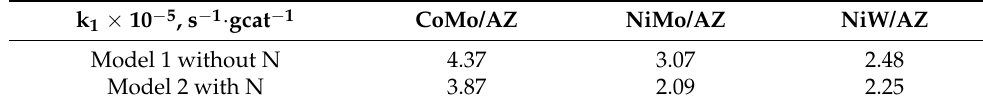
Table 3. The effects of Nitrogen introduction on the HDS kinetic rate